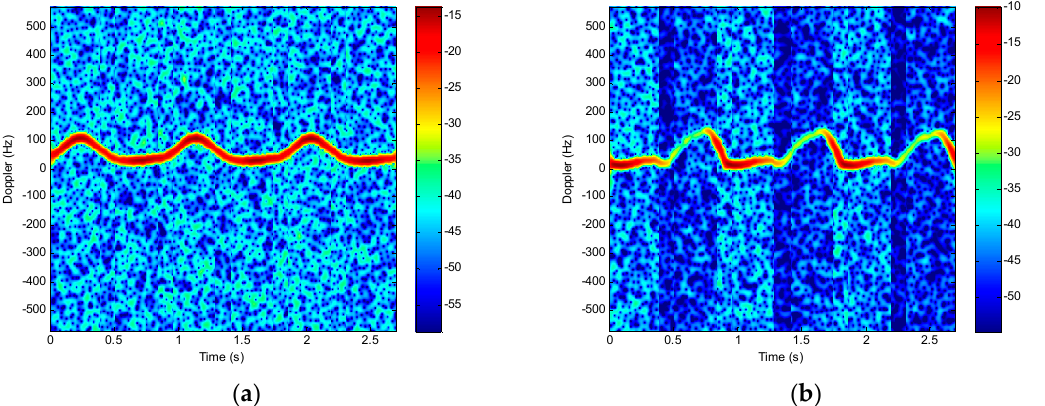
Figure 12. Decomposition results of IMF2 signals: ( a ) TFD of AMD1; ( b ) TFD of AMD2.